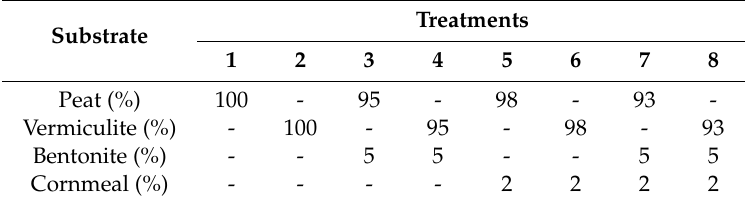
Table 1. Substrates and their combinations tested in order to R. solani pathogenicity. Substrate